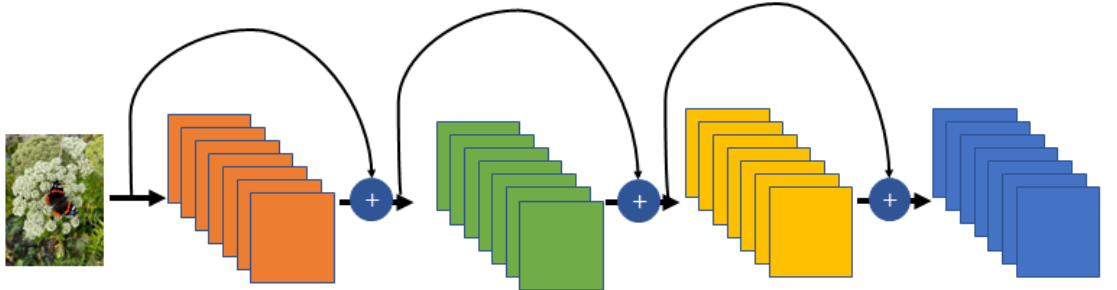
Figure 14. Basic structure of ResNet. ResNet is composed of the conventional feedforward of the CNN structure and residual connection.